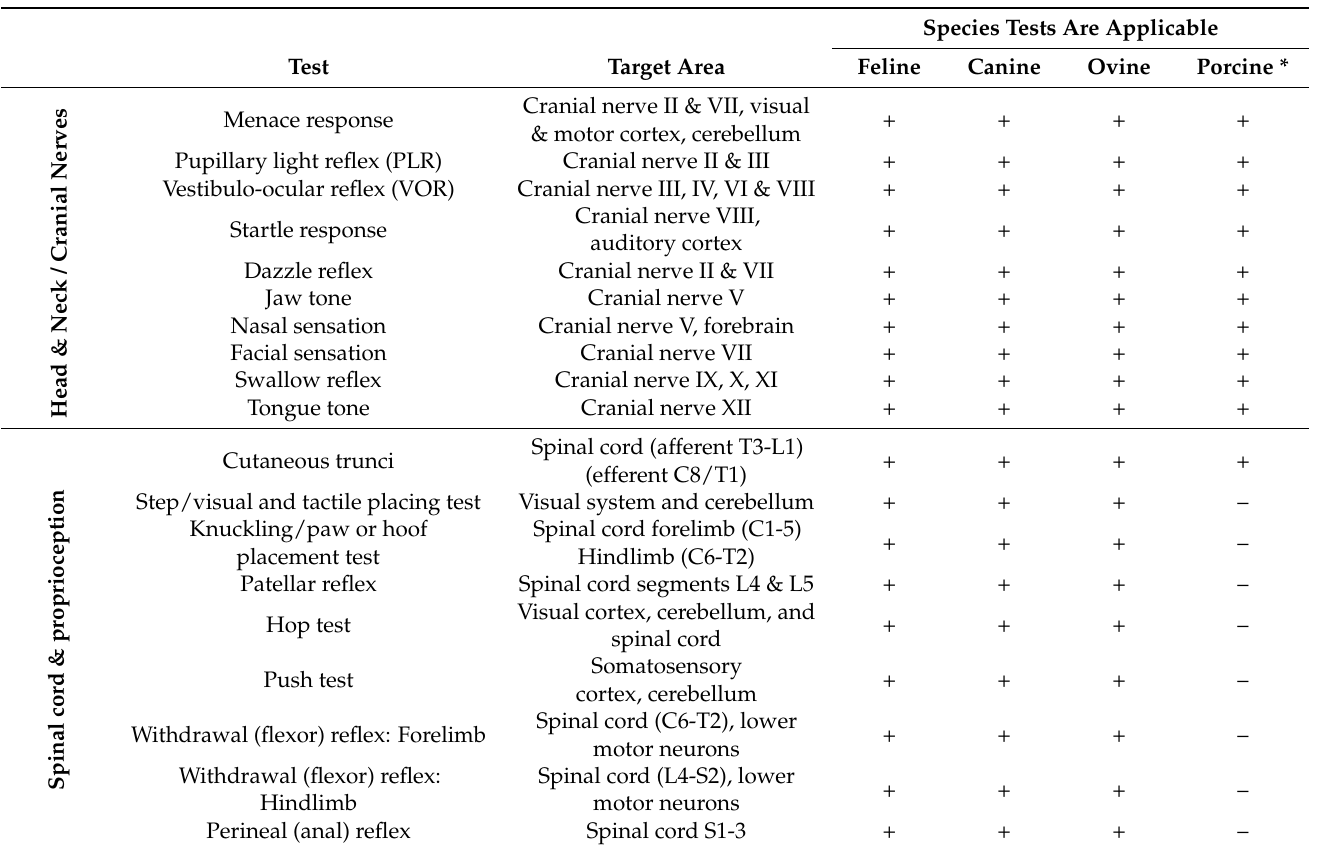
Table 2. Validity of clinical assessment procedures to determine site-specific neurological deficits in different large animal